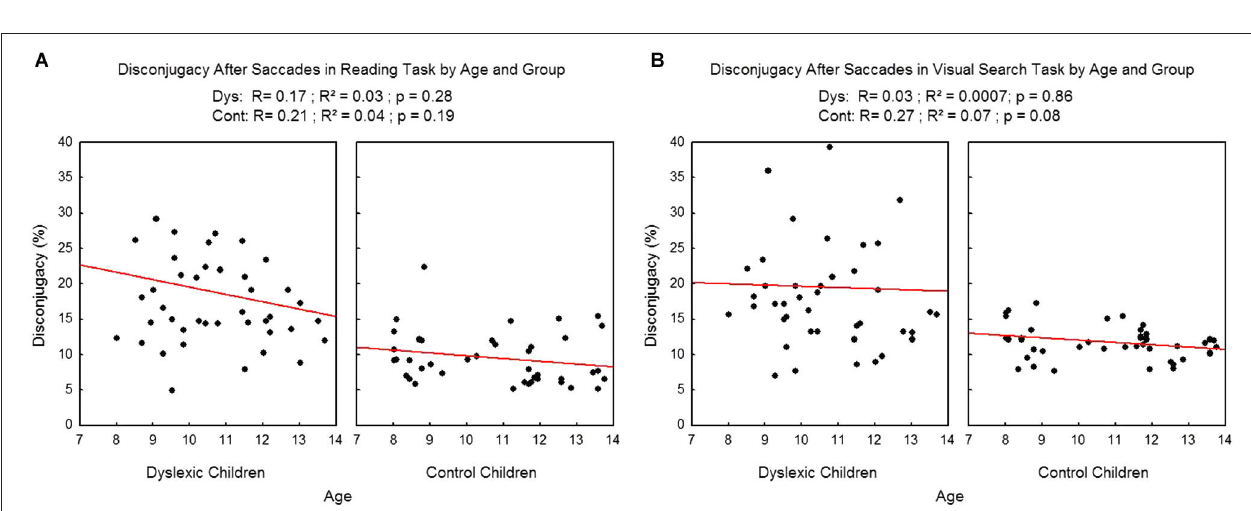
FIGURE 8 | Disconjugacy after the saccades in the reading (A) and visual search tasks (B) for both group of subjects . Lines represent the corresponding